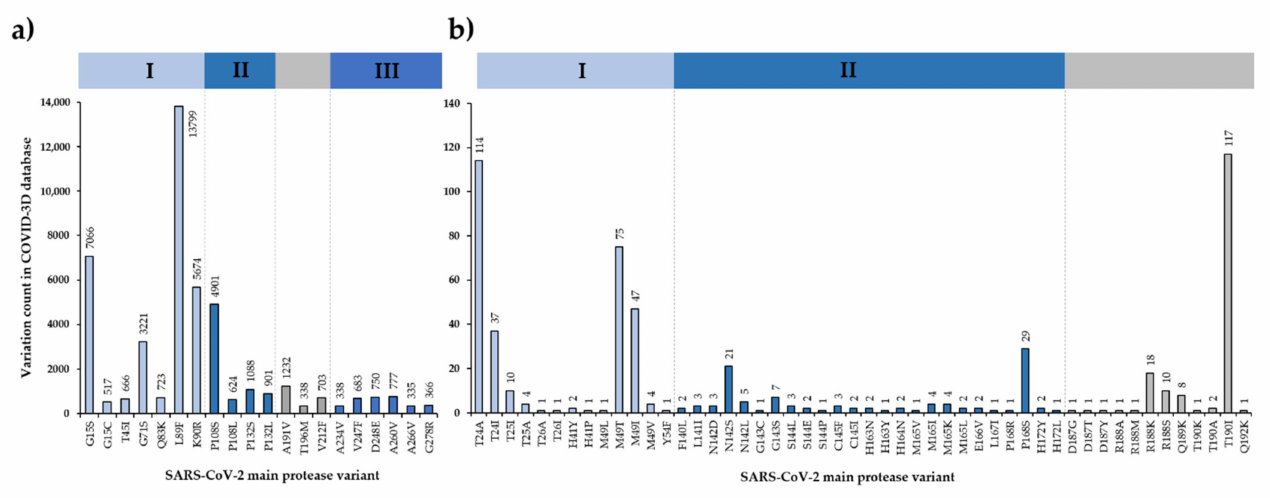
Figure 4. SARS-CoV-2 Mpro sequence variations based on COVID-3D database. Top20 varia- tions: residues with more than 300 known variants ( a ). Mutation frequency of active-site residues involved in the binding of nirmatrelvir ( b ). The database was accessed at 14 January 2022. The bars are colored based on domain organization (domain I–III are blue, while the linker between domain II and III is